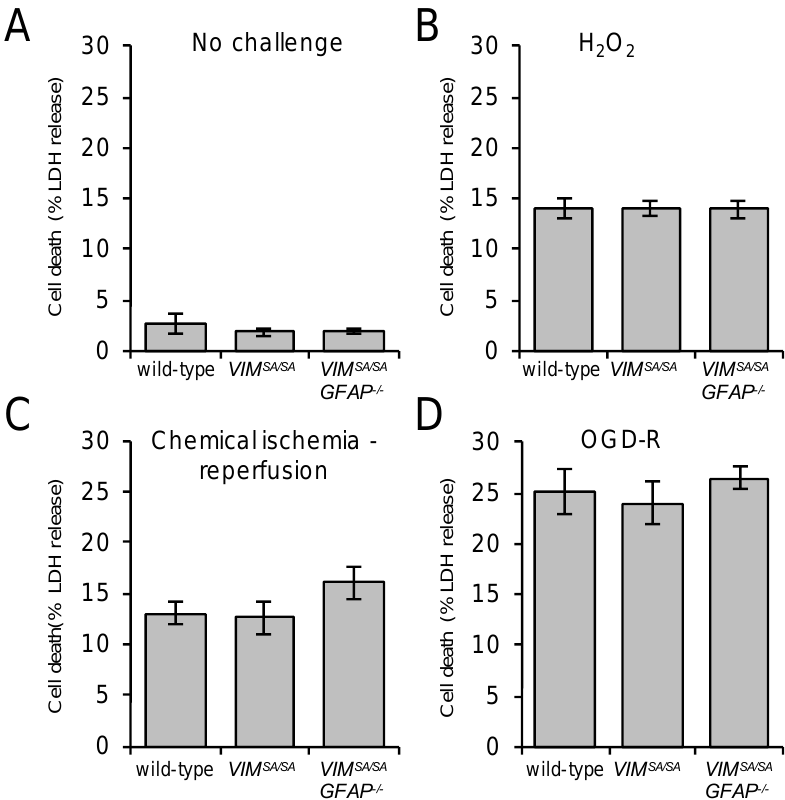
Figure 7. VIM SA / SA and VIM SA / SA GFAP − / − immature astrocytes show normal vulnerability to H 2 O 2 , chemical ischemia, and oxygen / glucose deprivation. Immature wild-type , VIM SA / SA , and VIM SA / SA GFAP − / − astrocyte cultures were incubated in ( A ) normal media with the B27 supplement to replace serum (no challenge), ( B ) exposed to H 2 O 2 (500 µ M) in HBSS bu ff er for 2 h, ( C ) exposed to chemical ischemia for 2 h followed by 2 h of reperfusion, or ( D ) exposed to oxygen / glucose deprivation for 18 h followed by 2 h of reperfusion (OGD-R). Cell death was measured as percentage of LDH release. N = 9, 5, and 10, respectively.